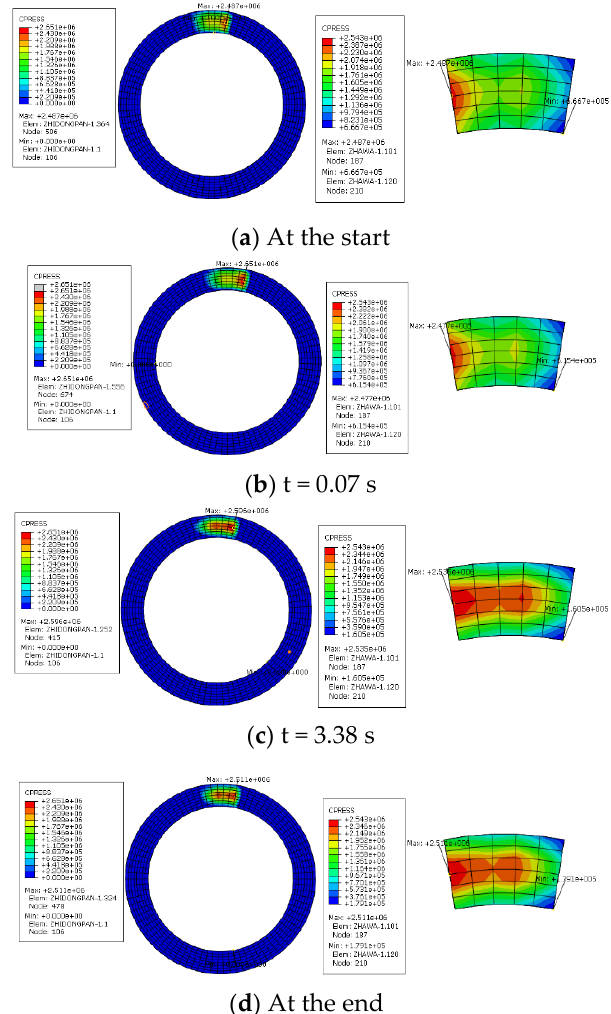
Figure 10. Contact pressure distributions of contact surfaces of brake disc and brake shoe during emergency braking.